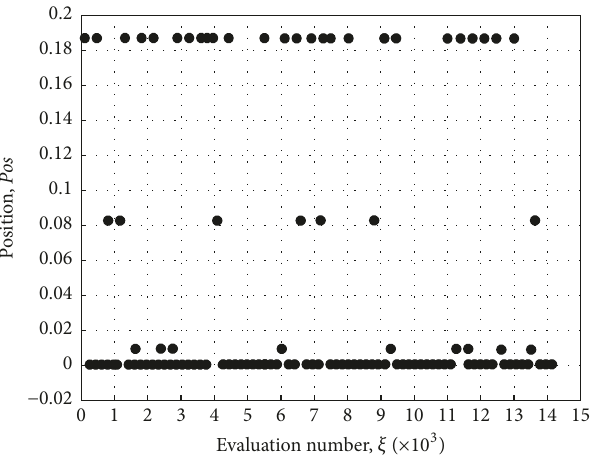
Figure 8: Behavior of the cluster center position with regard to